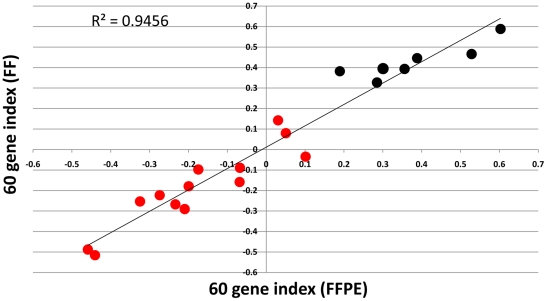
Comparison of the 60 gene index as derivative of the 70 gene prognosis signature of the FFPE samples to the 60 gene index of the paired FF samples.Scatterplot of the Pearson correlation of the 60 genes from each sample to the average expression profile of the good outcome patients as described in [17], [33]. This correlation is defined as the 60 gene index. The circles are colored based on the diagnostic results for these patients of the customized MammaPrint 8-pack test [33]: red = high risk outcome, black = low risk outcome.